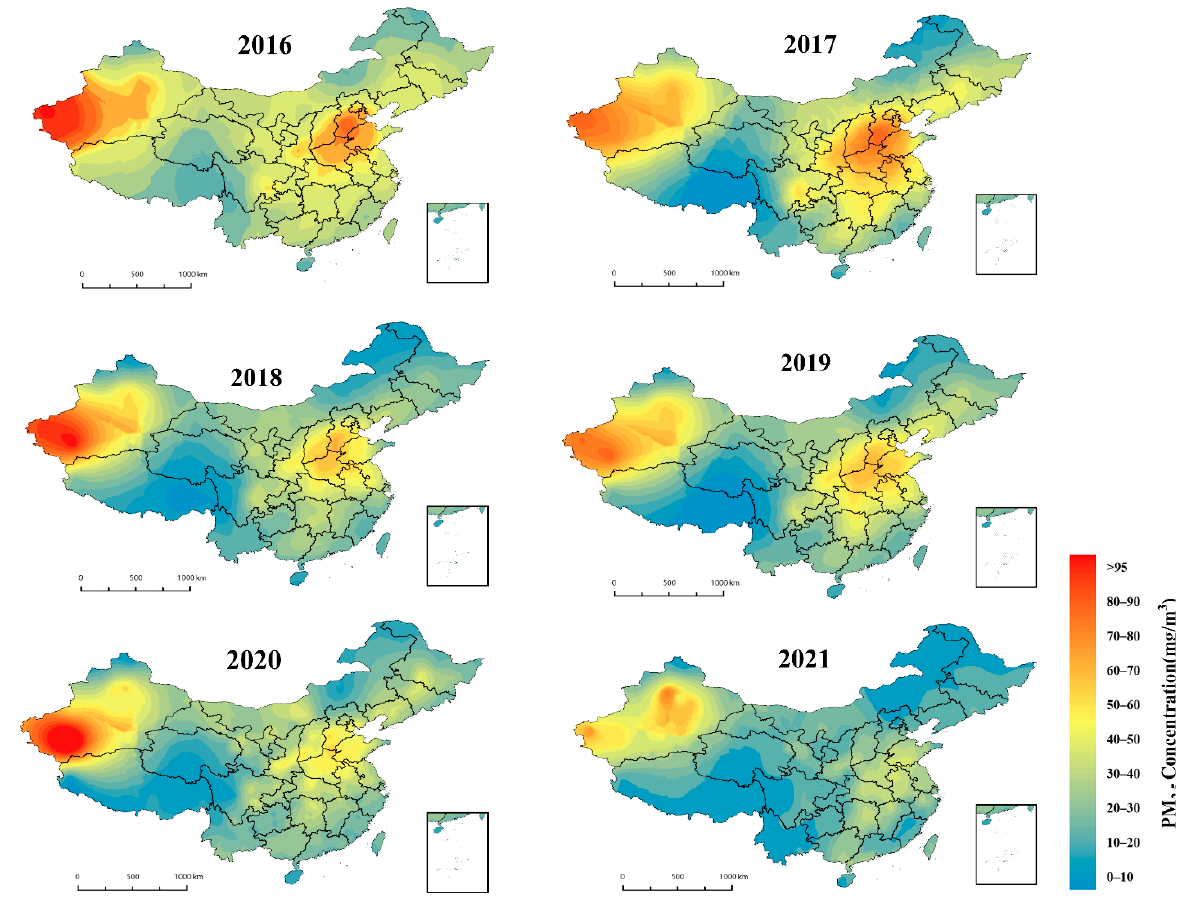
Figure 8. Simulated annual average distribution of PM 2.5 concentrations based on the LUR ‐ GBM model.